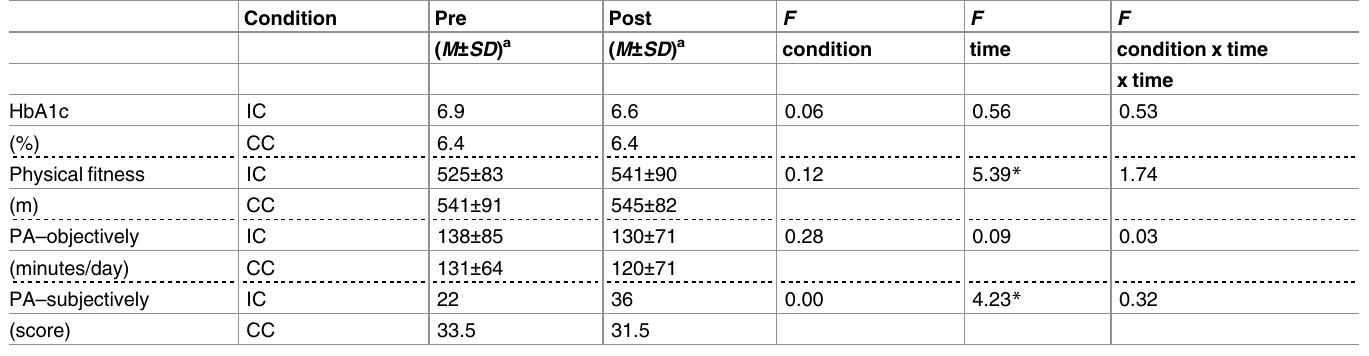
Table 5. Long-term